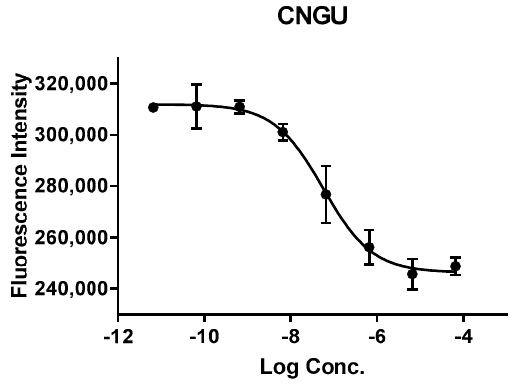
Figure 2. IC 50 curve of CNGU from a fluorescence-based NAALADase assay.